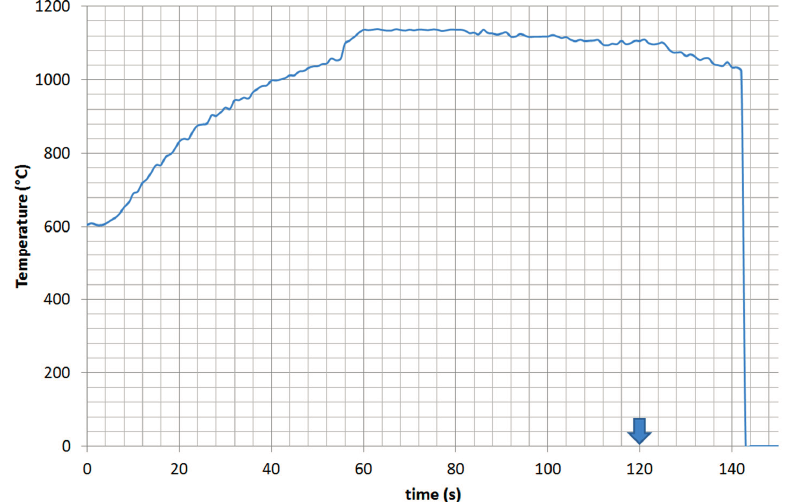
Figure 4. Heating curve of the Fe + Cr + Ni + Ti + Al powder compacts measured by sapphire fiber: microwave heating at 700 W forward power, 2450 MHz, in predominant magnetic field regions of the microwave applicator. Microwave exposure is prolonged after the reaction is terminated, until the time indicated by the arrow, resulting in a slope change during